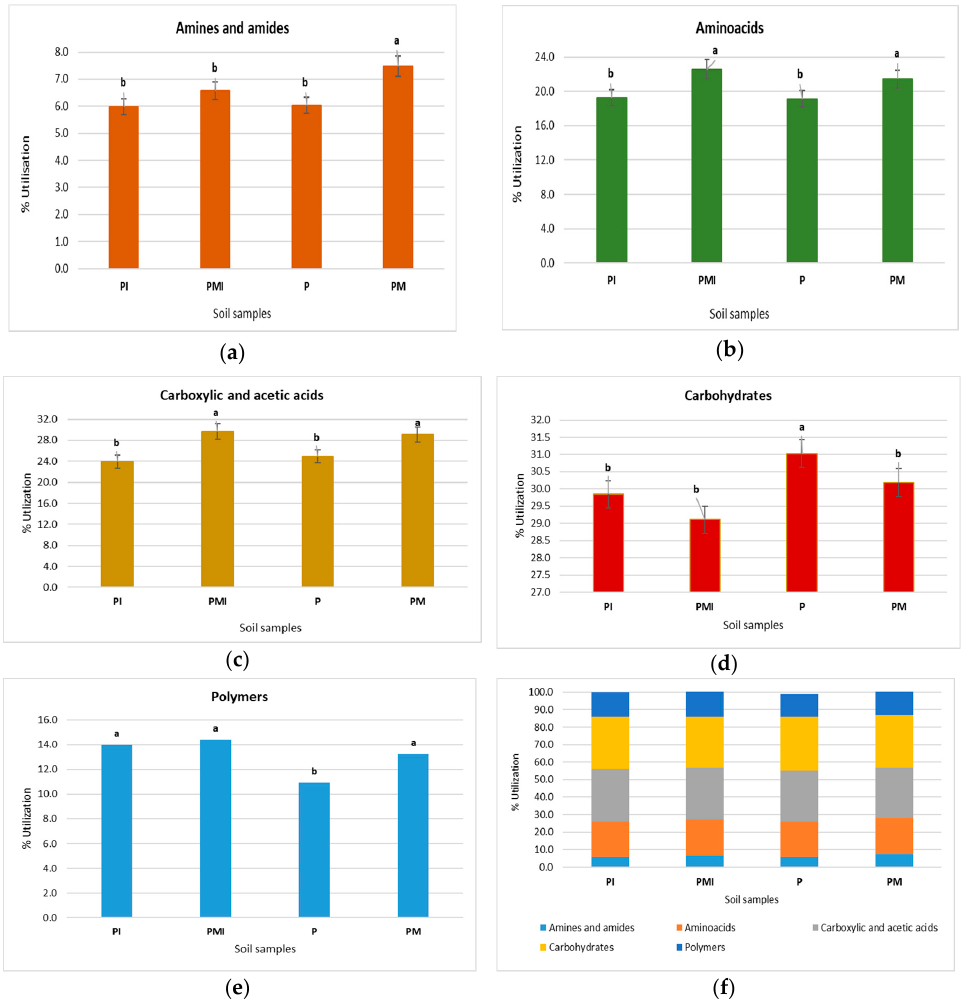
Figure 4. The percent of utilization of amines and amides, amino acids, carbohydrate, carboxylic acid, and polymers after 96-h incubation of Biolog EcoPlates. ( a ) Amines and amides, ( b ) amino acids, ( c ) carboxylic and acetic acids, ( d ) carbohydrates, ( e ) polymers, and ( f ) the percentage of total carbon source utilization in the soil. Treatment means separated by different letters are significantly different (Tukey’s mean separation test, p ≤ 0.05, n = 3).